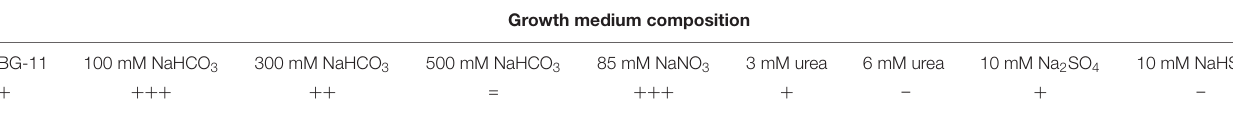
TABLE 2 | The effect of various carbon and nitrogen sources on the growth of Thermoleptolyngbya sichuanensis A183.